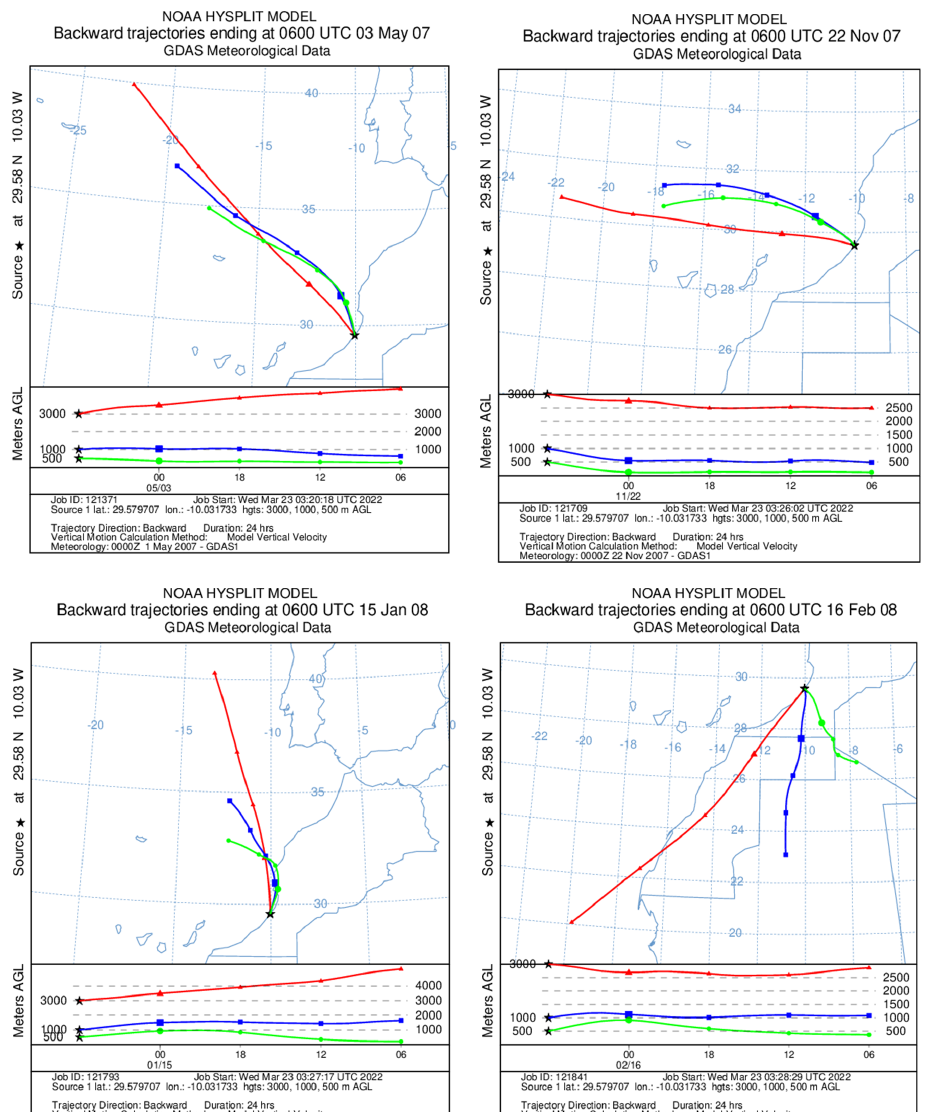
Figure 18. Some typical 24 h low elevation air mass backward trajectories from Mirleft at 6:00 (data every 6 h) corresponding to rain events. Colored lines represent the path of air masses starting at 3000 m (red triangles and lines), 1000 m (blue squares and lines), 500 m (green circles and lines) above the collection site. Data are taken every 6 h, corresponding to the points on the trajectories. From [68].